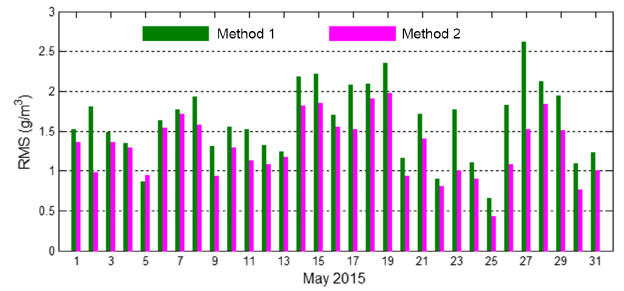
Figure 10. Bias comparison of two methods from 1 to 31 May 2015.